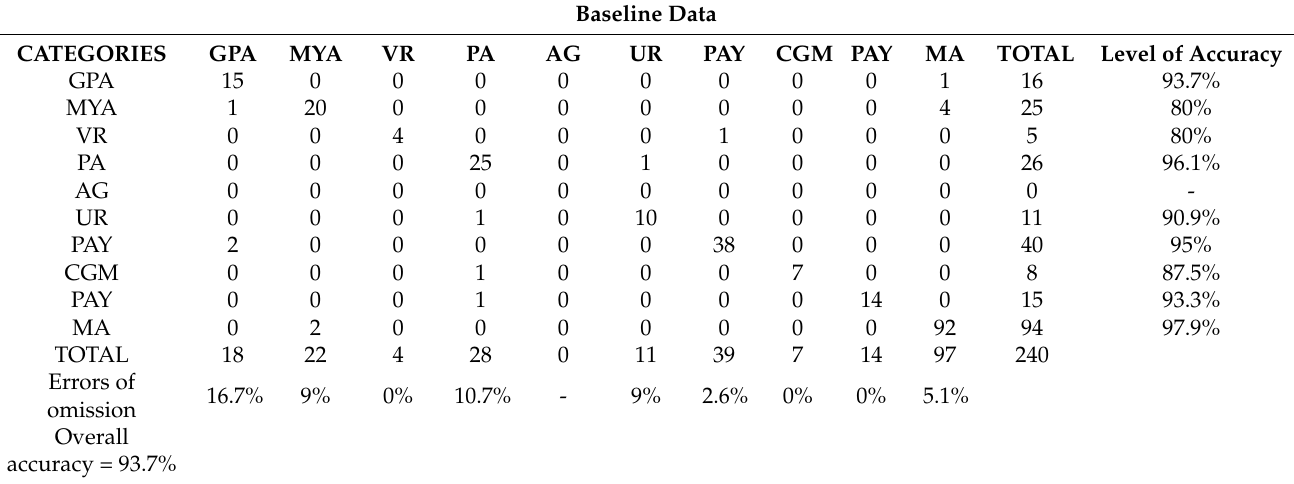
Table 6. Separability matrix derived using the transformed divergence method on Landsat-8 image of Trinidad-Valle de los Ingenios,